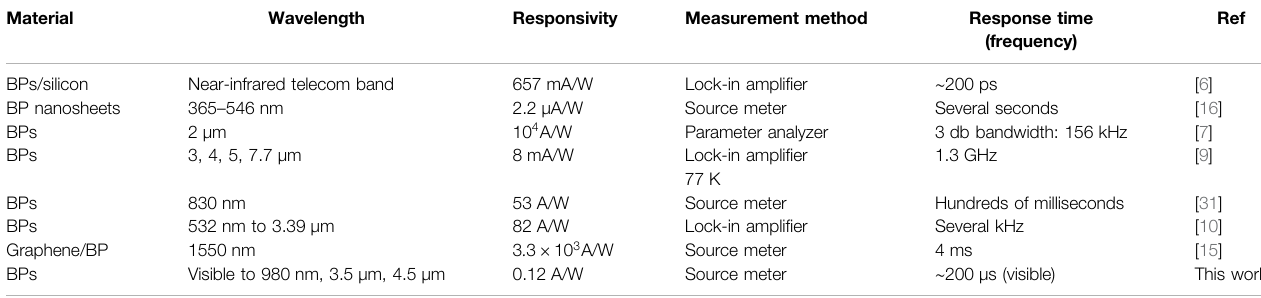
TABLE 1 | A summary of black phosphorous photodetectors.